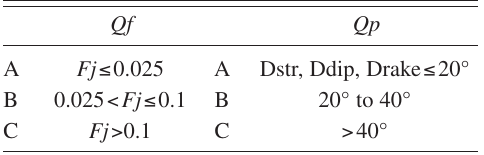
Table V. Fault-plane solution quality factors Qf and Qp . Fj is the solution prediction misfit to the polari- ty data. Dstr, Ddip, and Drake represent ranges in the variability of strike, dip, and rake, respectively. Qf Qp Fj ≤ 0.025 0.025 < Fj ≤ 0.1